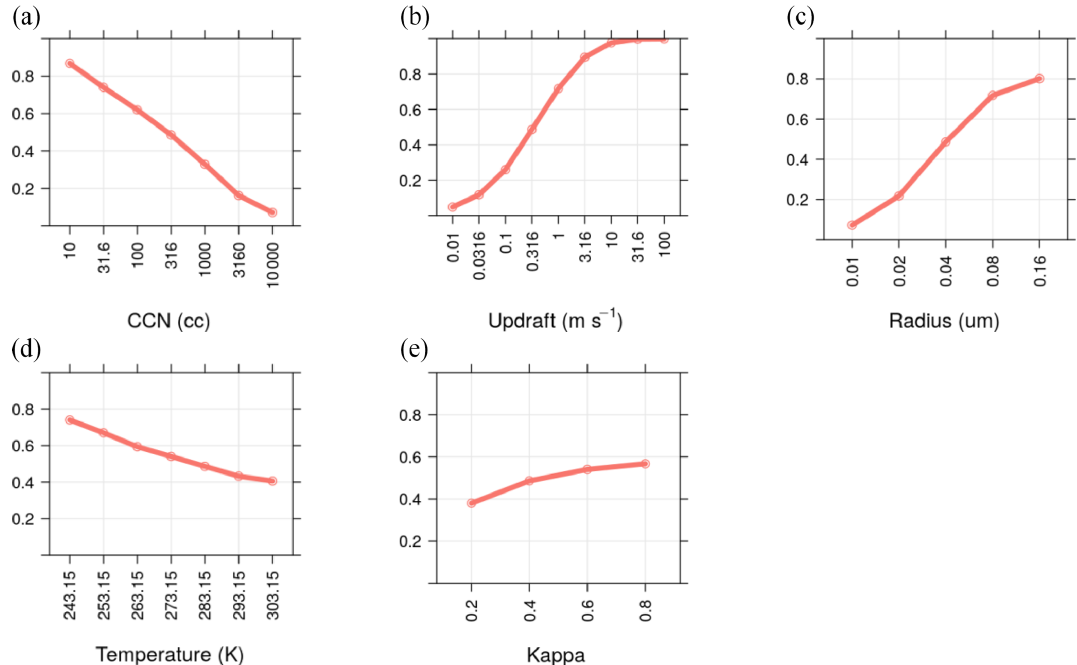
Figure 2. CCN activation look-up table. Activated fraction in response to (a) CCN concentration, (b) updraft speed, (c) CCN radius, (d) ambient temperature, and (e) kappa (hygroscopicity). For each plot, the remaining four variables are kept constant as follows: CCN is 316cm − 3 , updraft is 0.316ms − 1 , radius is 0.04µm, temperature is 283.15K, and kappa is 0.4. Table 1. WRF model scenarios summary. Updraft refers to minimum updraft speed.